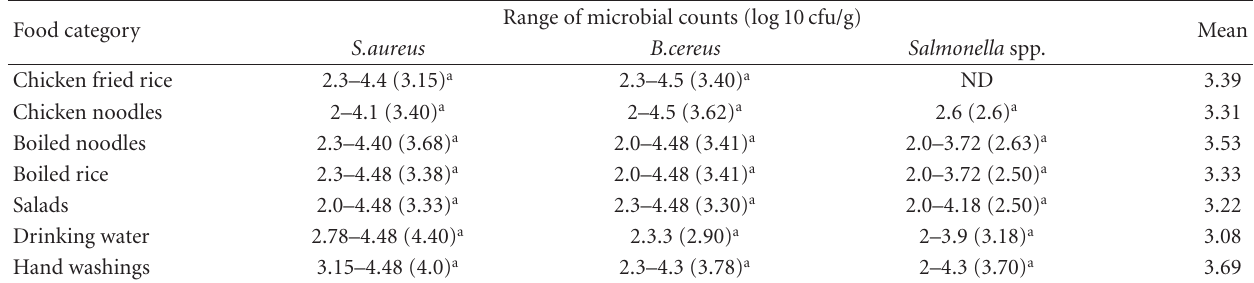
Table 2: Mean concentration ranges of foodborne pathogens in various samples. Food